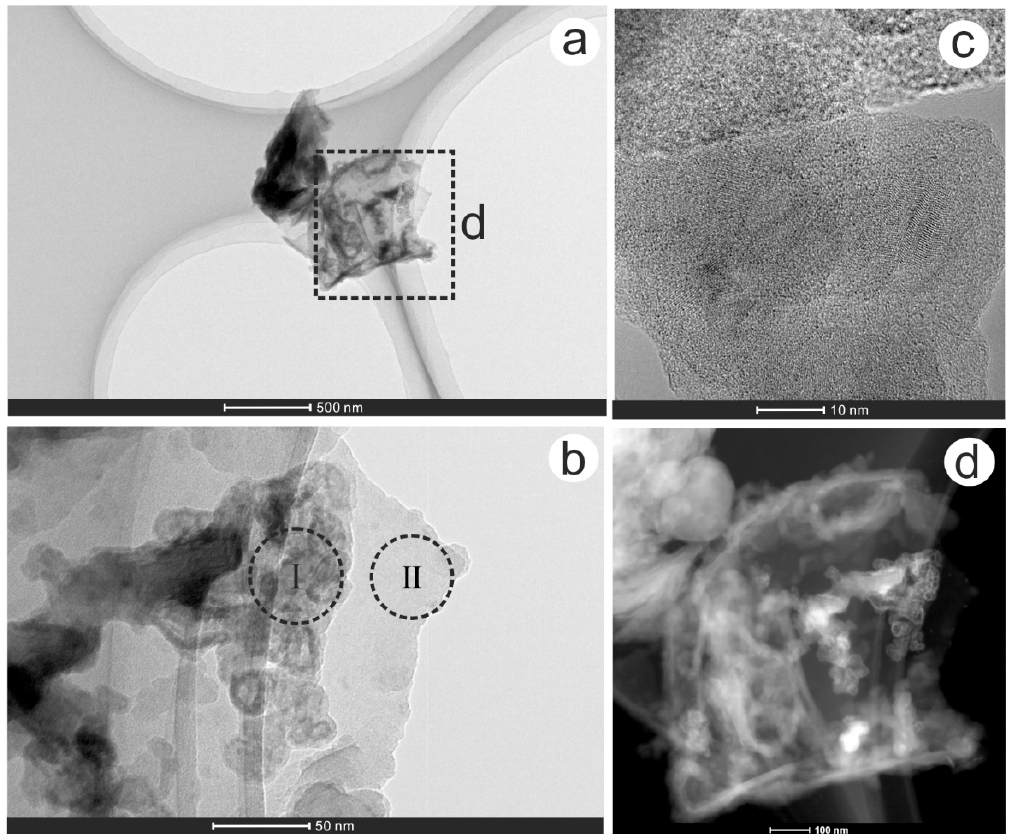
Figure 9. A Cu-bearing particle in the studied fault gouges; ( a ) TEM image; ( b ) TEM image; ( c ) HRTEM image; ( d ) STEM-HAADF image. Some small nanoparticles adsorb on the surface of a big particle.